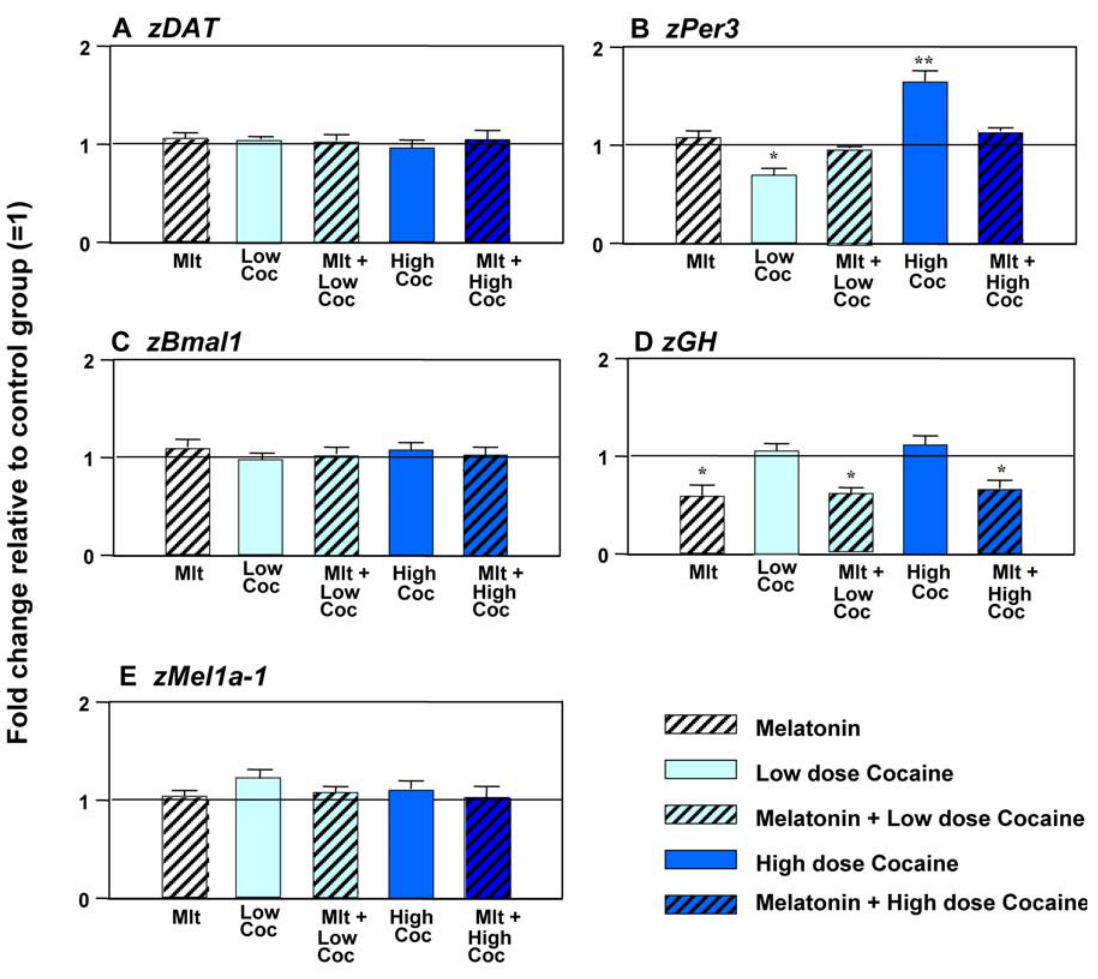
Figure 3. Nighttime low- or high-dose cocaine exposure fails to alter the expression ofzDAT,zBmal1,zGHand melatonin receptor genes during zebrafish development but continues to affect zPer3, and this effect is counteracted by melatonin. (A–E) Melatonin (100 nM for 45 min), Low (0.3 m M) or High (30 m M) cocaine doses (15 min), with or without melatonin pre-treatment (100 nM, 30 min) administered to 36-hpf embryos. N=3– 4 samples/treatment group, 25 embryos per sample. Mean 6 SEM, t -test (vs. control), * p , 0.05, ** p , 0.01, *** p , 0.001; One way ANOVA (between treatments), a: p , 0.05, vs. cocaine-only group. Mlt-melatonin; Coc-cocaine.